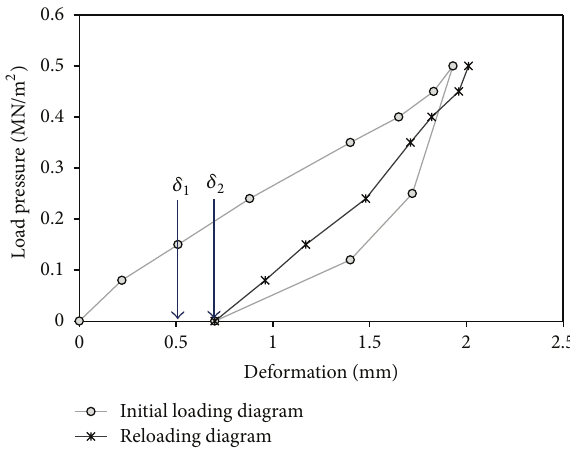
Figure 2: Determination of 𝛿 1 and 𝛿 2 .